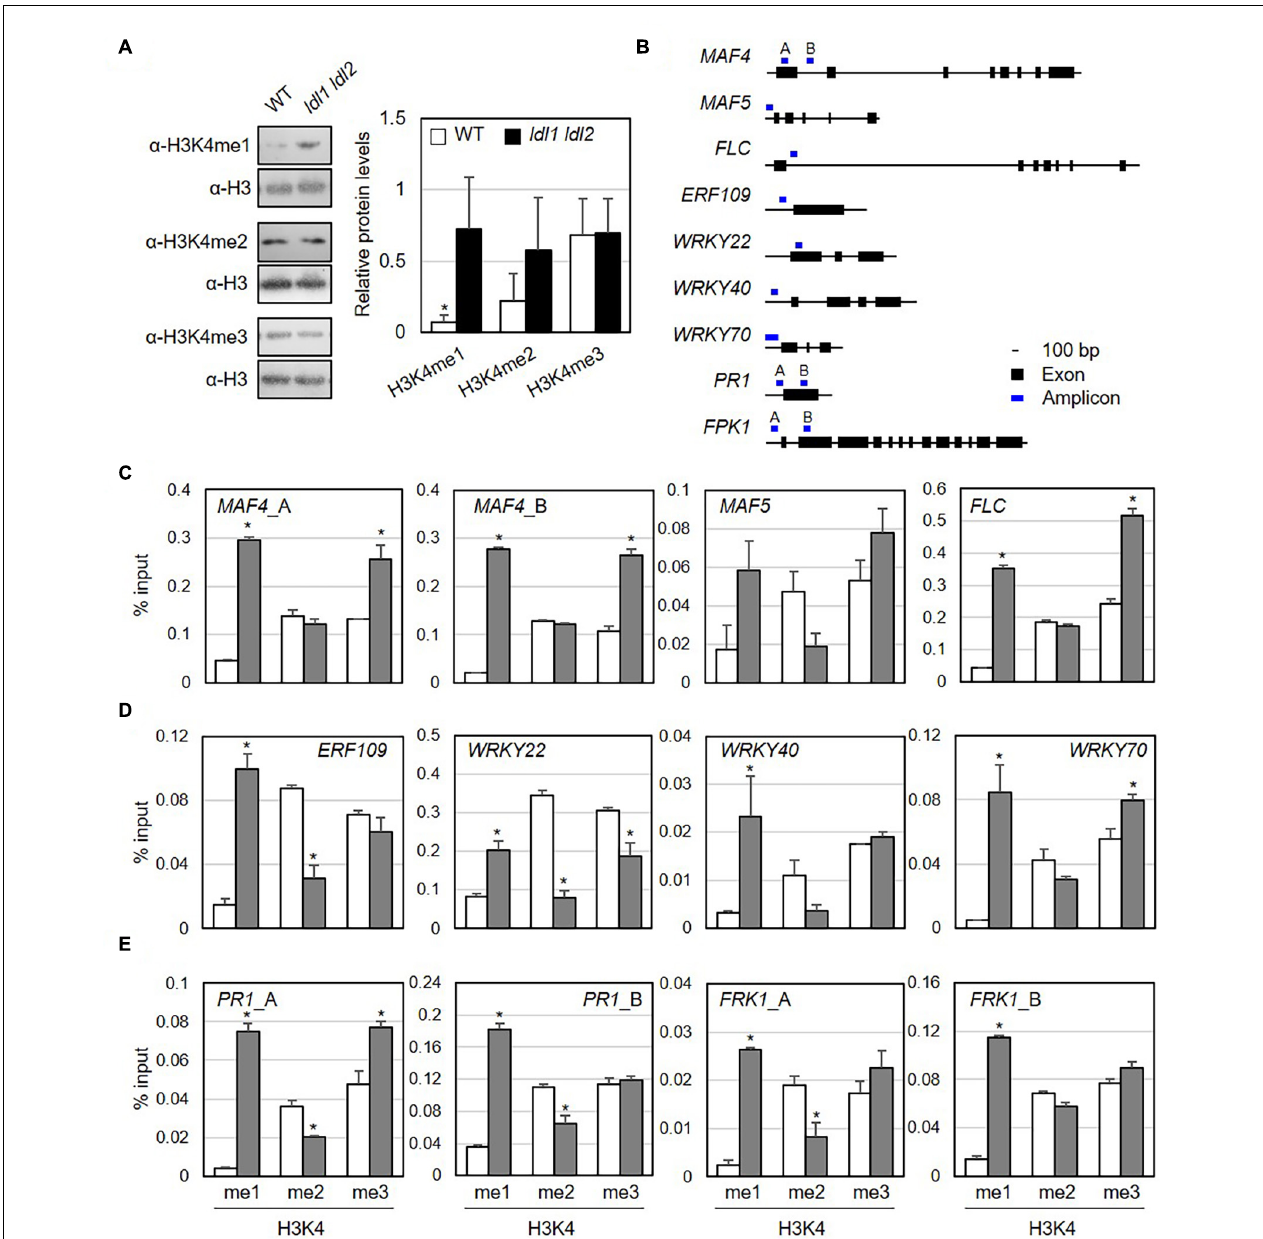
FIGURE 5 | Monomethylation of histone H3K4 is associated with the transcription of genes encoding transcription factors in Arabidopsis . (A) Abundance of H3K4me1, H3K4me2, and H3K4me3 marked proteins in WT and ldl1 ldl2 plants. The right panel shows modified histone H3 protein levels in Arabidopsis (average ± SD, * p < 0.05, Student’s t -test, n = 3). The results of all independent experiments are shown in Supplementary Figure 6 . (B) Genomic DNA regions of gene-specific primers used in panels (C-E) . (C-E) ChIP-qPCR to examine the enrichment of modified histone H3 proteins in the identified LDL1-target genes (C) , transcription factors overrepresented in the ldl1 ldl2 mutants (D) , and PR1 and FRK1 genes (E) . Enrichment of Lys 4- mono-, Lys 4- di-, and Lys 4-trimethylated histone H3 protein at the chromatin regions of genes was measured in wild type (white bars) and ldl1 ldl2 (gray bars). The amount of DNA after ChIP was quantified by qPCR, and the means represent the average immunoprecipitation efficiencies (%) against total input DNA used. Each plot shows a representative of two independent biological replications (with similar results), and the data points are the average values of technical triplicates (average ± SEM, * p < 0.05, Student’s t -test, n = 3). The blue bars are the amplicon regions used for ChiP-qPCR, and the primer sequences used in this study are shown in Supplementary Table 2